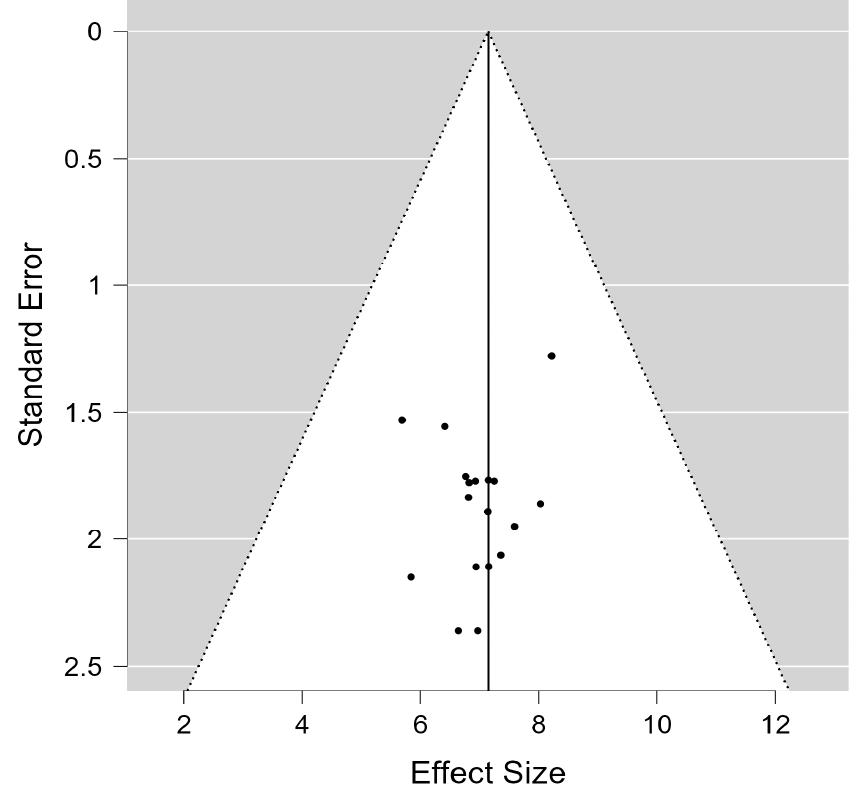
Figure 5. Funnel plot of educational subscale. Table 7. Model comparison: Random effects (MM), Z-distribution, Fisher’s